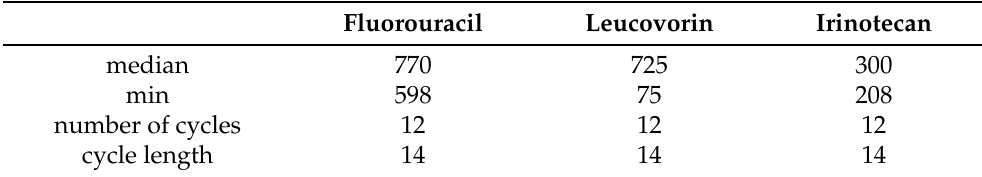
Table 3. Drug dosages in